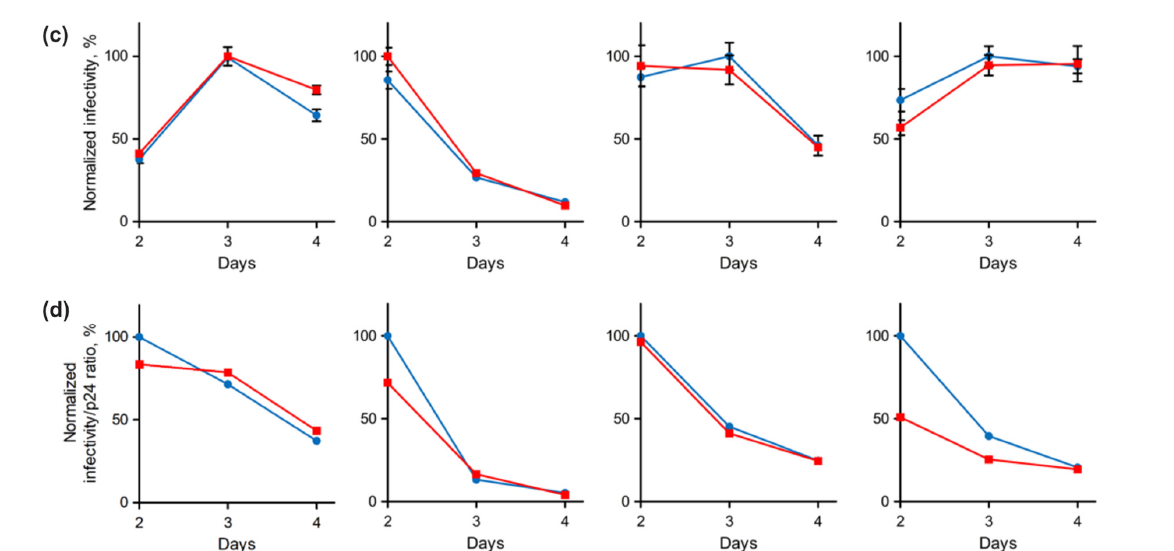
Figure 8. Kinetics of HIV-1 infection of T-cells isolated from donors in Ctrl or 100 nM supplemented conditions ( a – e ). ( a ) Schematic of the experimental procedure used to follow the different parameters of viral production and cell infection over four days. Similar to what was done with Jurkat in Figure 7, the media were collected at different time points and evaluated for the levels of p24 ( b ), infectivity of TZM-bl cells ( c ) and the ratio of infectivity over p24 levels ( d ) ( n = 1). The infectivity assays were assessed with technical triplicates. For panels ( b – d ), the maximum value was arbitrarily set as 100%. 2.5. The Infection of Primary T Cells with HIV-1 Altered the Levels of Certain